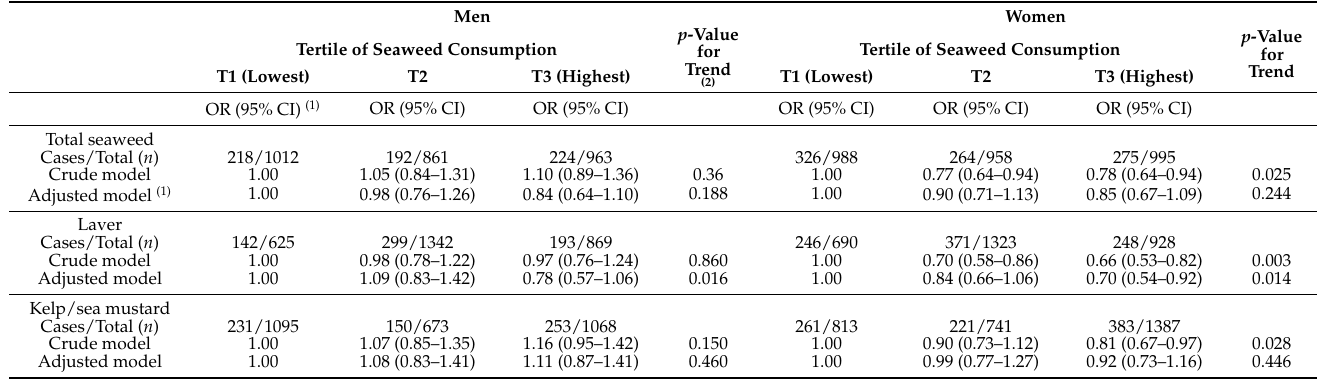
Table 3. Odds ratios (ORs) and 95% confidence intervals (CIs) of metabolic syndrome according to tertiles of total seaweed, laver, and kelp/sea mustard consumption in the Korean Genome and Epidemiology Study (Ansan and Ansung).